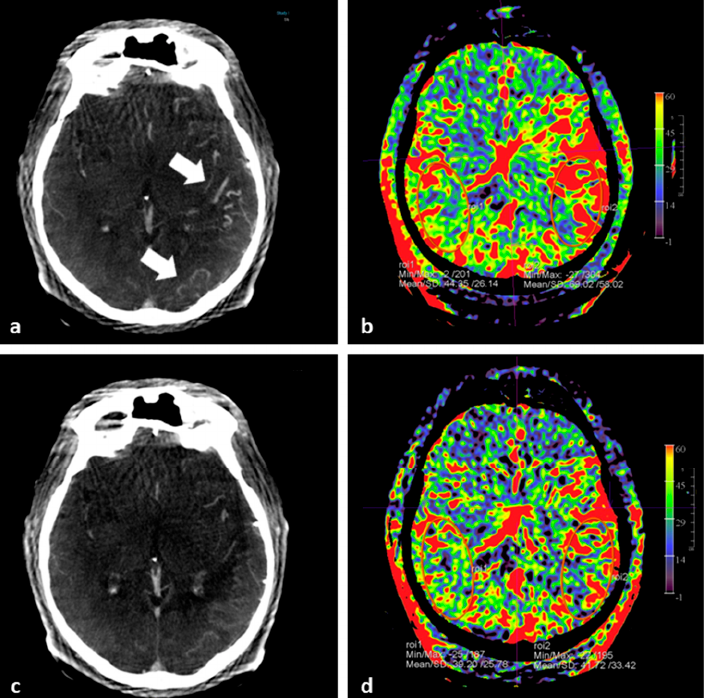
Figure 8. FD CT PBV imaging in DAVF treatment. ( a ) Axial FD CT fill run MIP reformation before treatment shows clearly the dilated and congested cortical cerebral veins at the right (white arrows). ( b ) Corresponding axial pretreatment PBV MIP reformation demonstrates elevated PBV values compared to the right side. ( c ) Axial fill run MIP reformation after partial embolization exhibits a clear diminishing of the cerebral venous congestion. ( d ) Post embolization axial PBV image